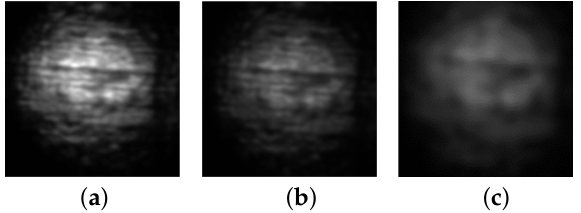
Figure 10. Comparison between unfiltered and Gaussian filtered images. ( a ) Unfiltered, ( b ) Filtered, σ = 20, ( c ) Filtered, σ = 30.